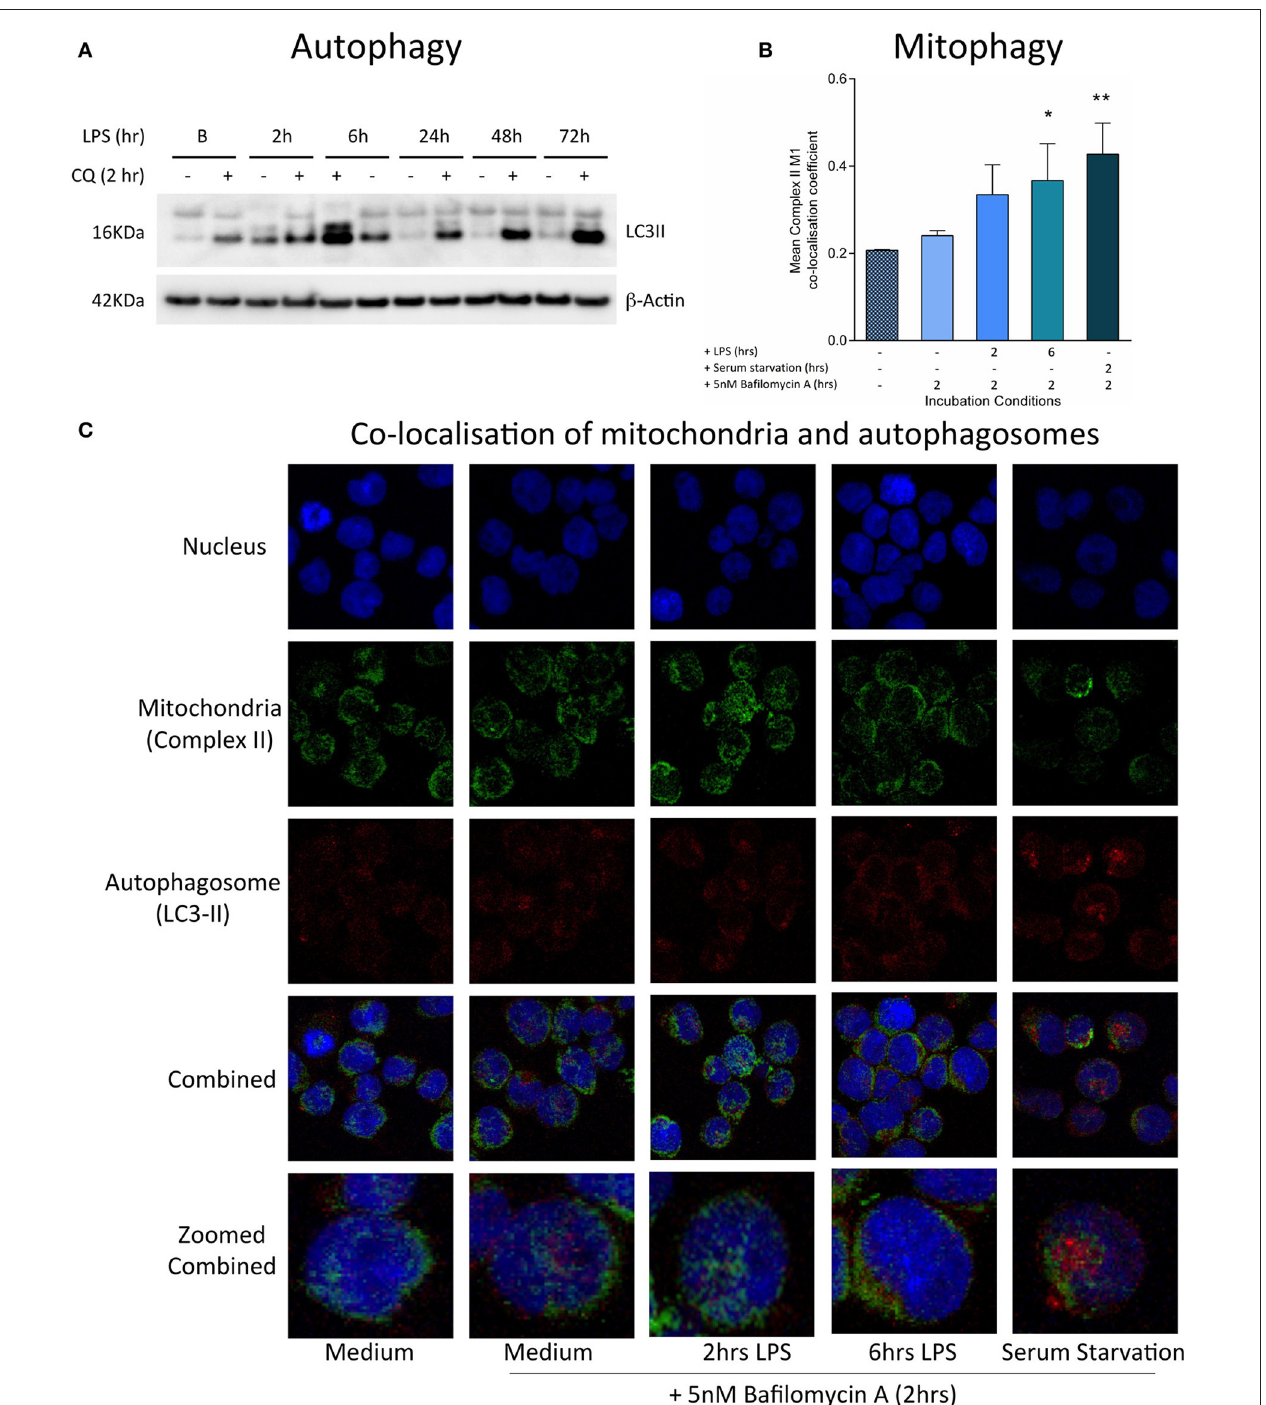
FIGURE 3 | Induction of mitophagy in THP-1 cells following exposure to LPS. THP-1 cells were incubated with LPS (100ng/ml) before measuring the levels of autophagy and mitophagy. (A) Autophagic flux was assessed by measuring the accumulation of LC3-II relative to β -actin using Western blot ( n = 3). (B) Confocal microscopy provided a measure of mitophagy by measuring the co-localisation of mitochondrial complex II with the autophagosome marker LC3-II using the Mander’s M1 co-localisation co-efficient ( n = 4). (C) Representative confocal microscopy images with staining for the nucleus (blue), mitochondrial complex II (green), and LC3-II (red) after incubation of THP-1 cells with LPS (100ng/ml) for 0–6h. In all experiments serum starvation was used a positive control and accumulation of autophagosomes was facilitated by treatment with 10 µ M chloroquine (CQ) or 5nM bafilomycin A1 for the final 2h. Data are presented as mean ± standard deviation; * p < 0.05, ** p <